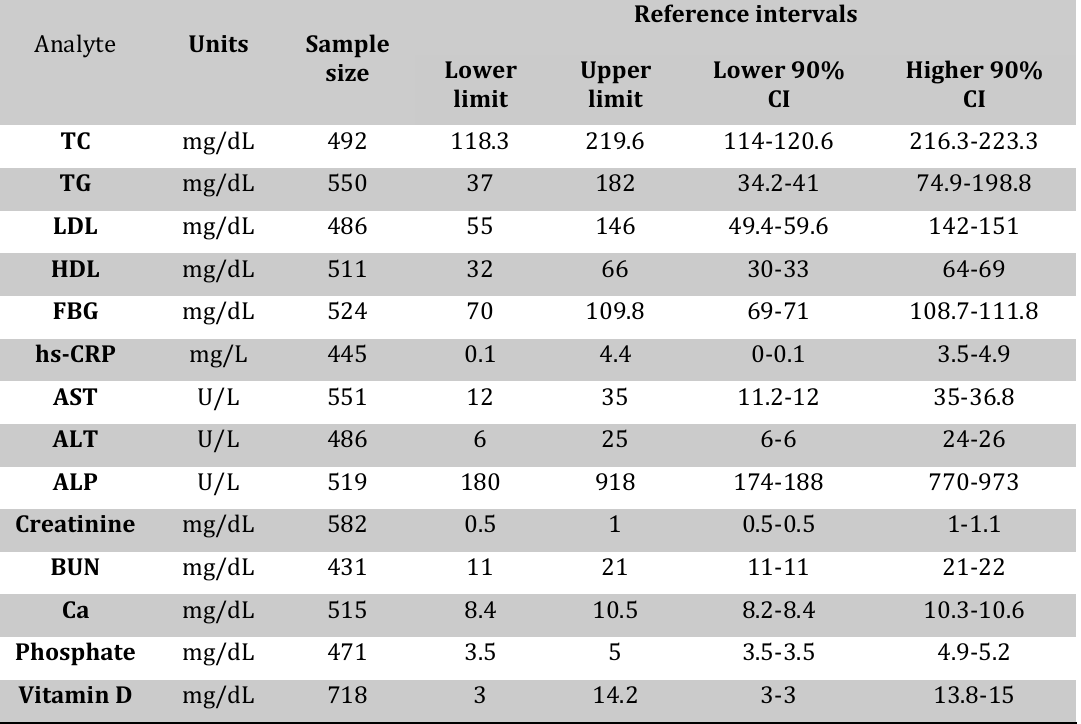
Table1. Lower and upper limits of RI of some routine biochemical tests with 90% confidence interval